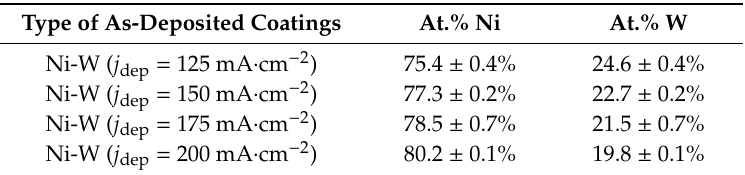
Table 1. Chemical composition of the as-deposited Ni-W alloy coatings determined by energy dispersive spectroscopy, in dependence on deposition current density. Type of As-Deposited